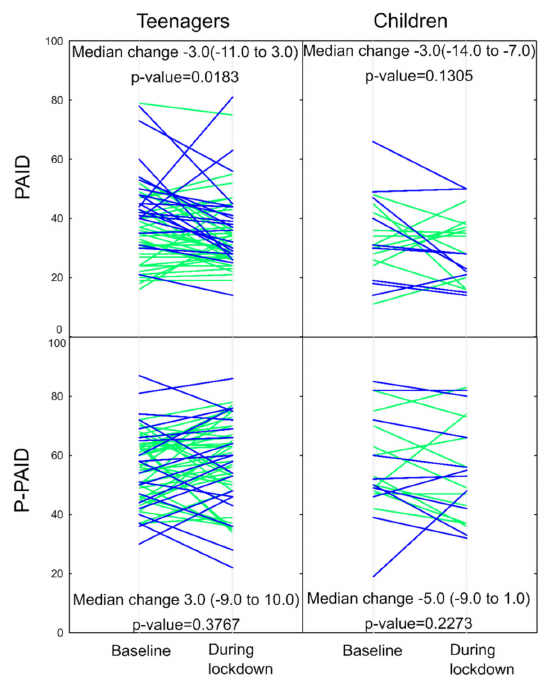
Figure 1. Diabetes-related distress expressed as PAID scores before (baseline) and during lockdown in children, teens and in their parents. Median change over time is shown for the whole group. Boys are denoted with light green, girls with blue. PAID—The Problems Areas in Diabetes in a Child or Teen; P-PAID—The Problems Areas in Diabetes in a Parent of Child or Teen. The PAID score decrease was evident in teenage girls ( − 7.0 ( − 17.0 to − 2.5)) but not in boys (0 ( − 9.0–5.0), for comparison of change in girls vs in boys p = 0.028, Table 2). In